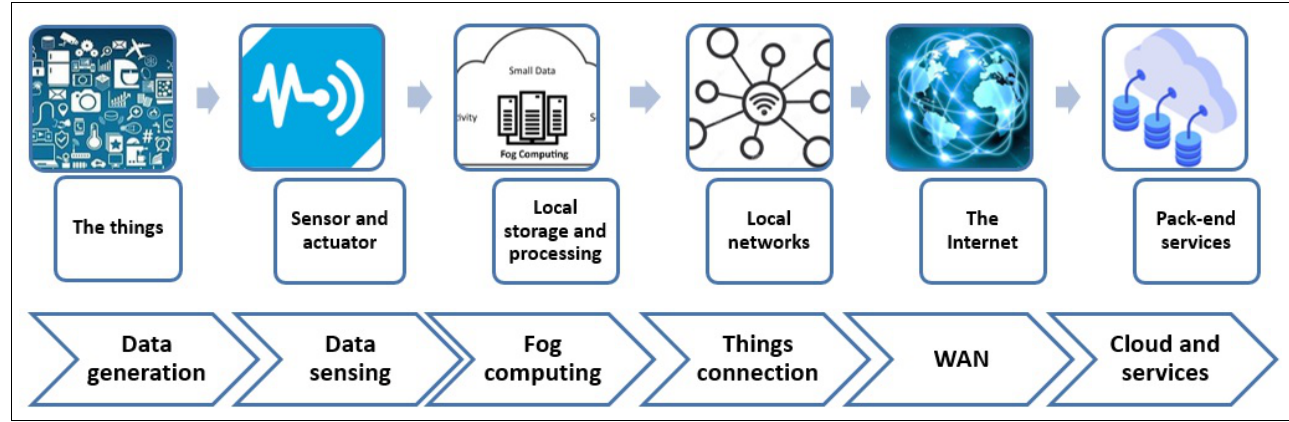
Figure 1. The IoT system